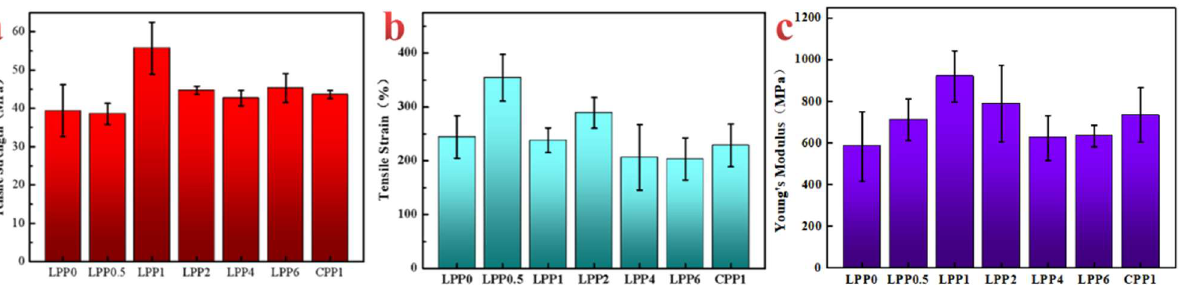
Figure 7. Mechanical properties of the films. ( a ) Tensile strength of the films; ( b ) tensile strain of the films; ( c ) Young’s modulus of the films.